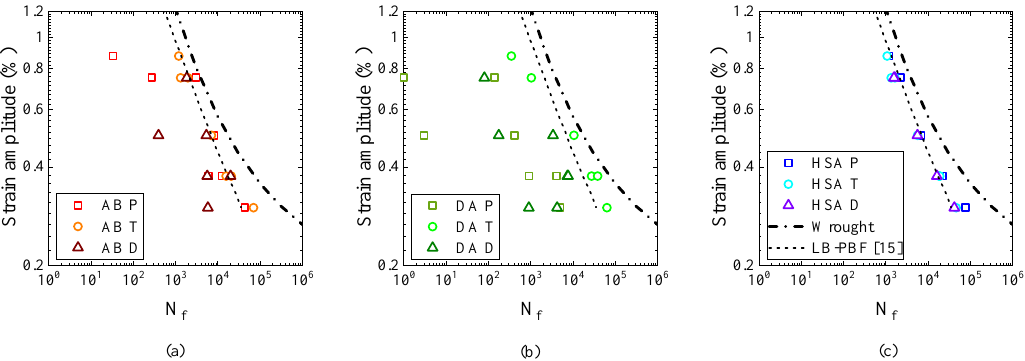
Figure 13. Strain vs. life plots for the different post-treatments. ( a ) AB condition. ( b ) DA condition. ( c ) HSA condition.